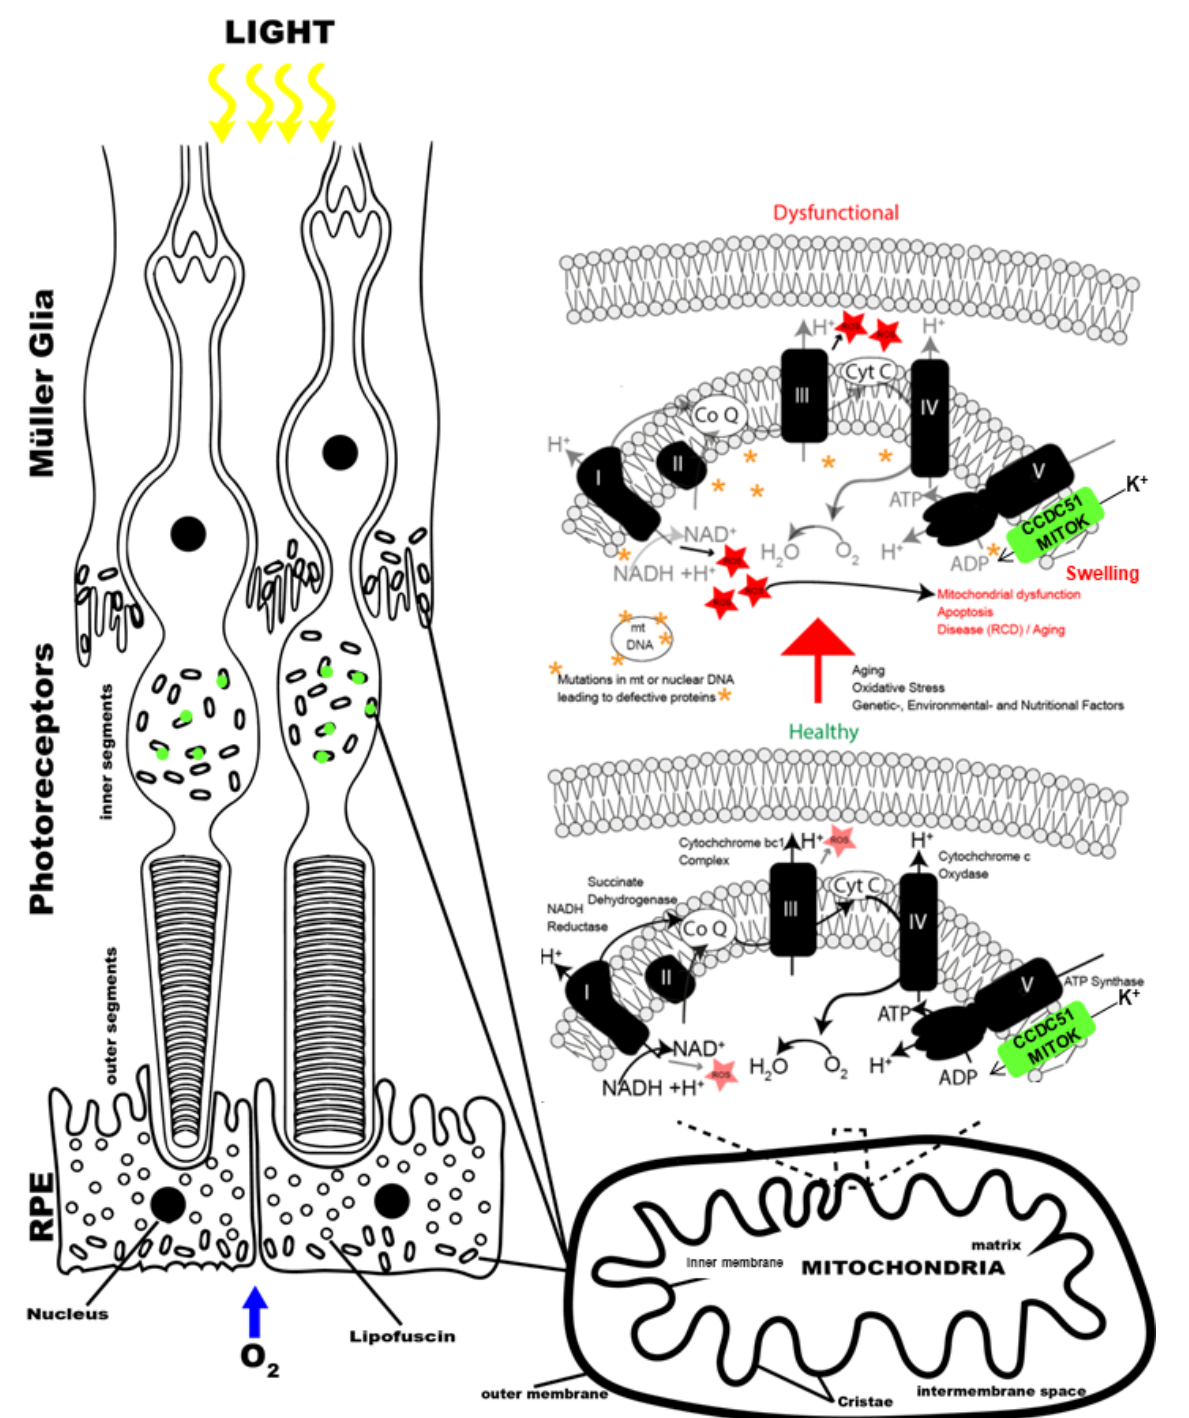
Figure 7. Schematic drawing of mitochondrial proteins in photoreceptor cells. ( Left ) outer retinal layers with mitochondria present in Müller glia, inner segment of photoreceptors, and retinal pigment epithelium. ( Right ) enlarged drawing of molecules implicated in mitochondrial function in healthy (bottom) and dysfunctional (top) conditions. The latter situation can be caused by mutations in mitochondrial or nuclear genes. (Figure adapted from [44]).